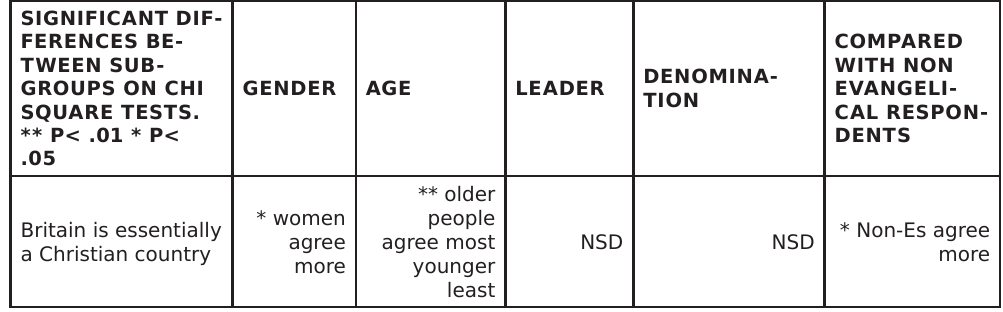
Some significant differences between